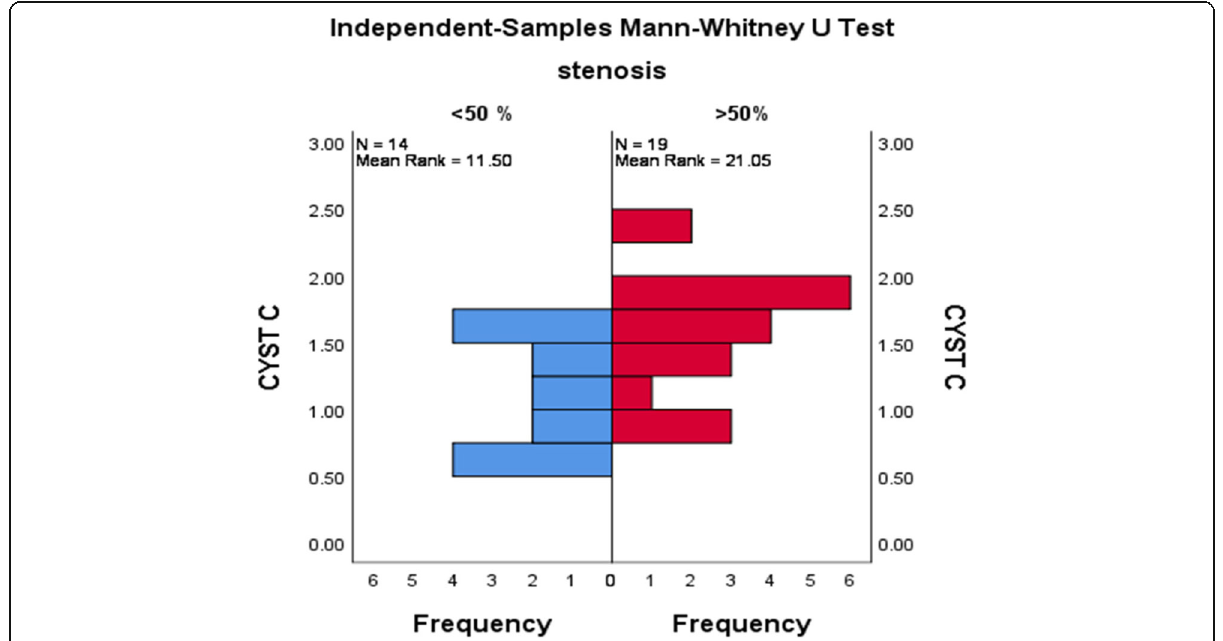
Fig. 2 Cystatin C level (mg/L) according to the degree of